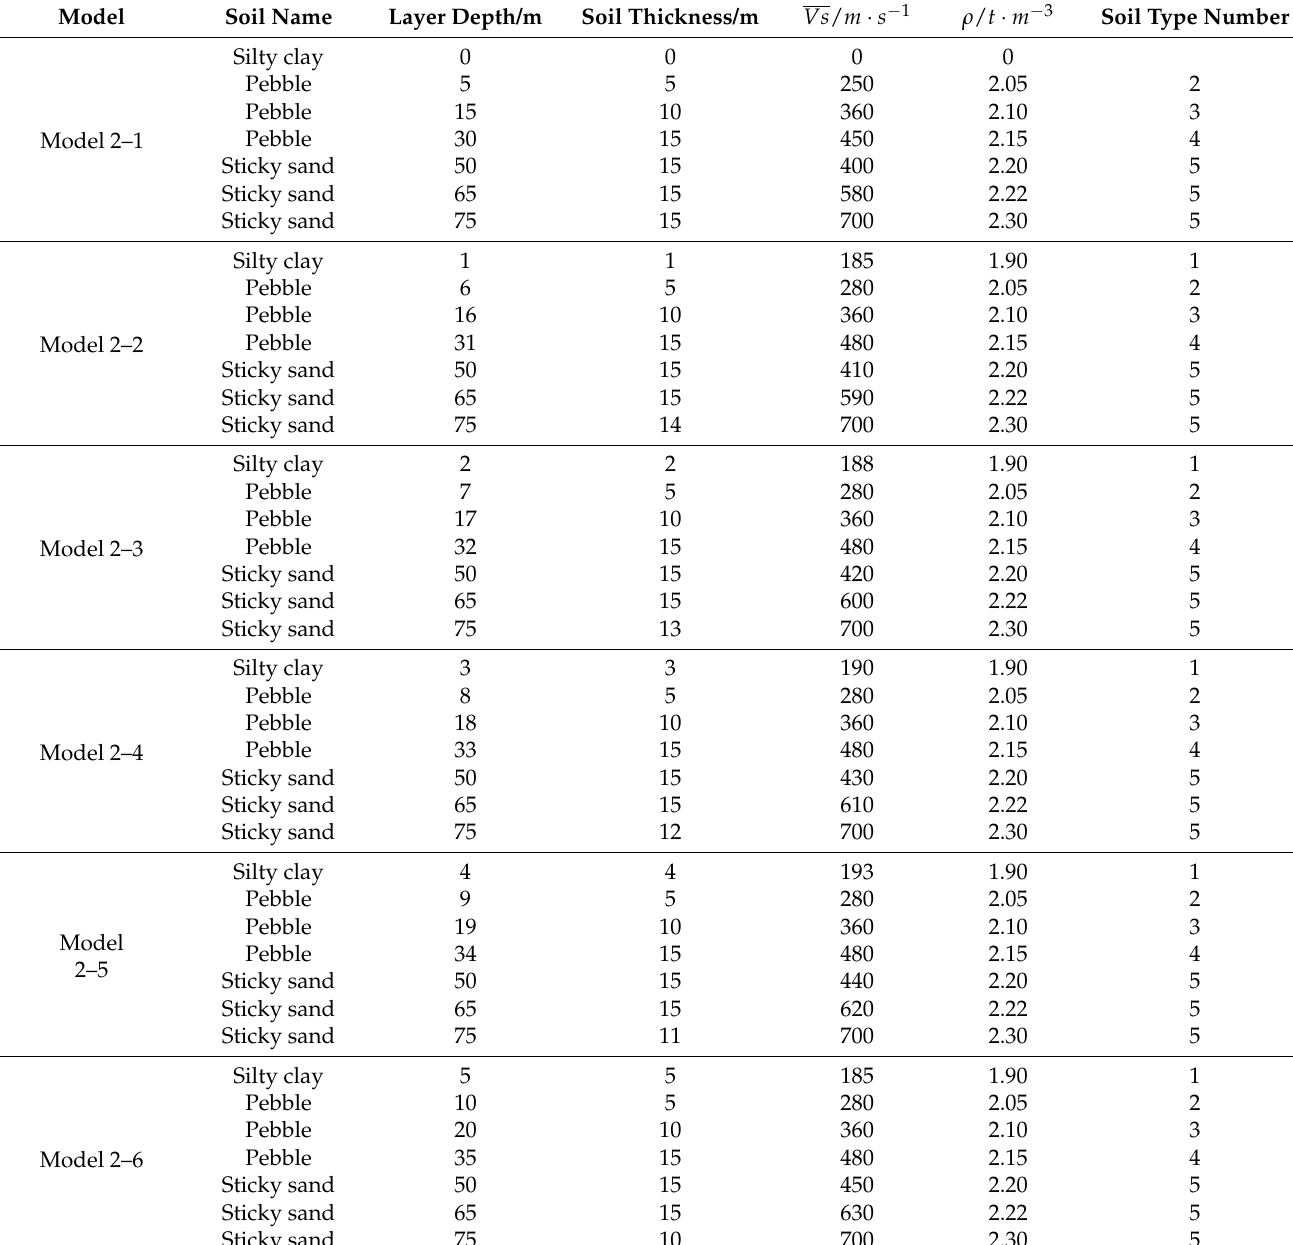
Table 3. Models and soil mechanical